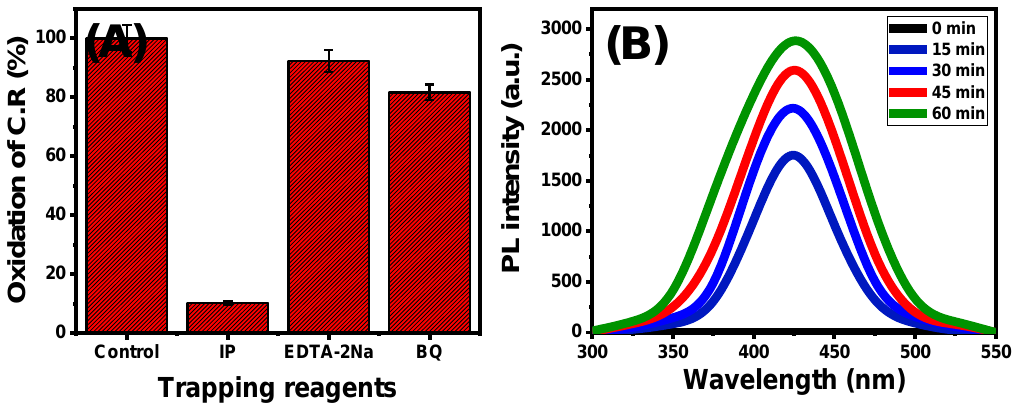
Figure 8. The results of the oxidizing species scavenging tests during the oxidation of C.R by MG/CFC ( A ) and the changes in the intensities of the PL spectra at different oxidation intervals ( B ). General Oxidation Mechanism